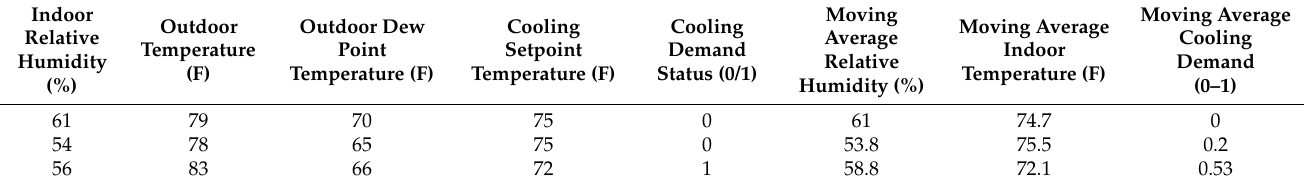
Table 3. Sample of synchronized Smart Wi-Fi thermostat, weather, and moving averages features for relative humidity